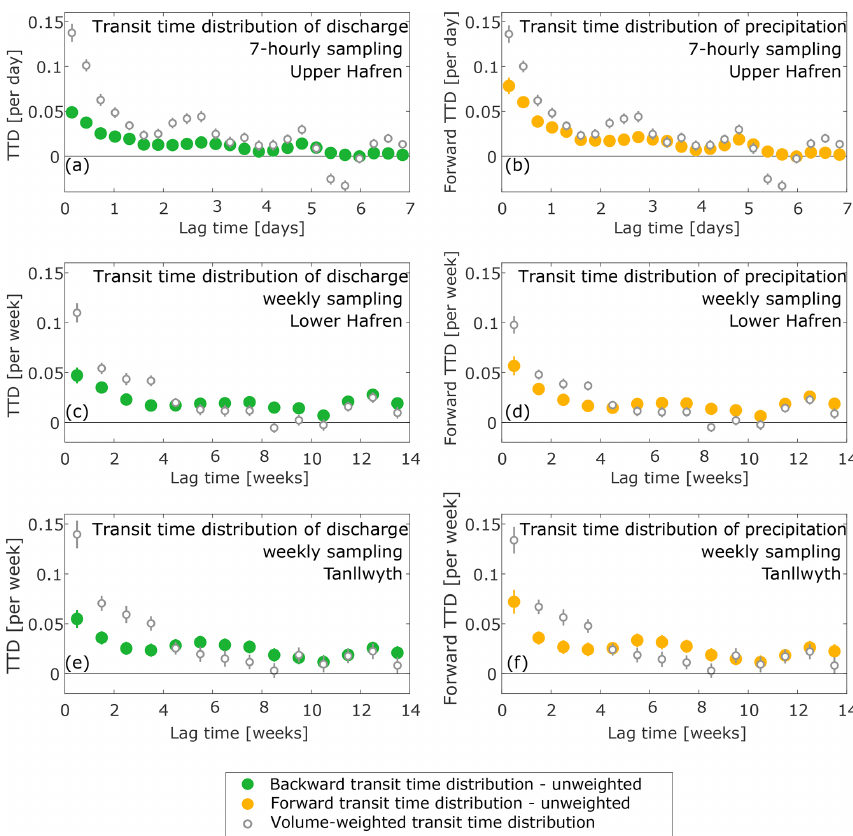
Figure 11. Transit time distributions of discharge (“backward” TTDs, left) and precipitation (“forward” TTDs, right) calculated from 7- hourly (a, b) and weekly (c–f) time series of oxygen-18. Solid circles indicate unweighted transit time distributions, whereas open gray circles indicate volume-weighted transit time distributions.